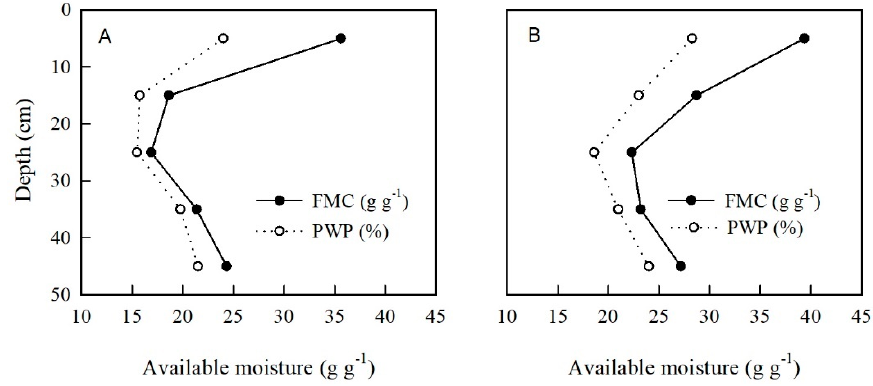
Figure 3. Available moisture under rotary tillage (RT; A ) and subsoiling tillage (ST; B ) at 0–50 cm depth in the experimental field in 2014 after tillage and before sowing. FMC, field moisture capacity; PWP, permanent wilting percentage (1500 kPa); Available moisture = difference between the values of FMC and PWP.